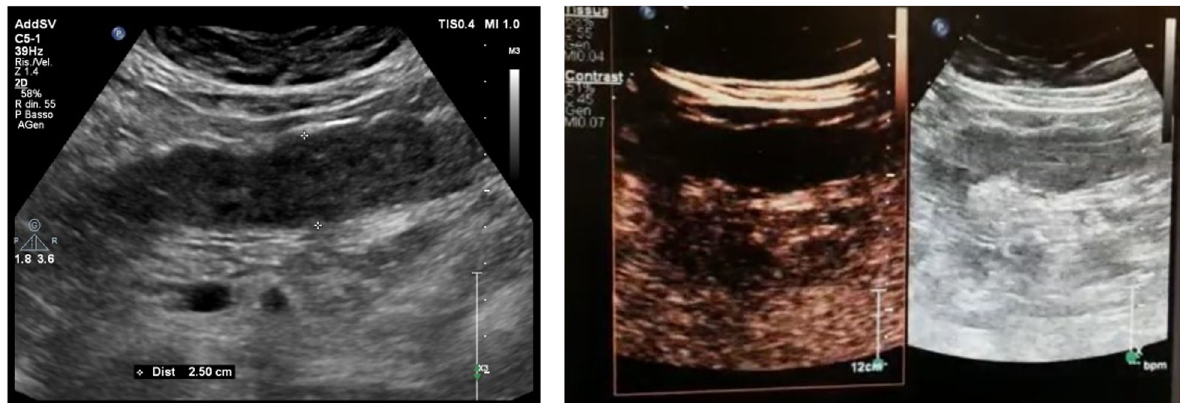
Figure 14. A dilated loop of the small intestine is visualized, with complete loss of wall stratification and diffuse hypoechoic appearance of the wall. In live examination, peristalsis was abolished at the level of that bowel tract. Upon CEUS, there was no parietal perfusion. Image obtained from a patient with newly diagnosed atrial fibrillation and diagnosis of intestinal ischemia (embolic nature).